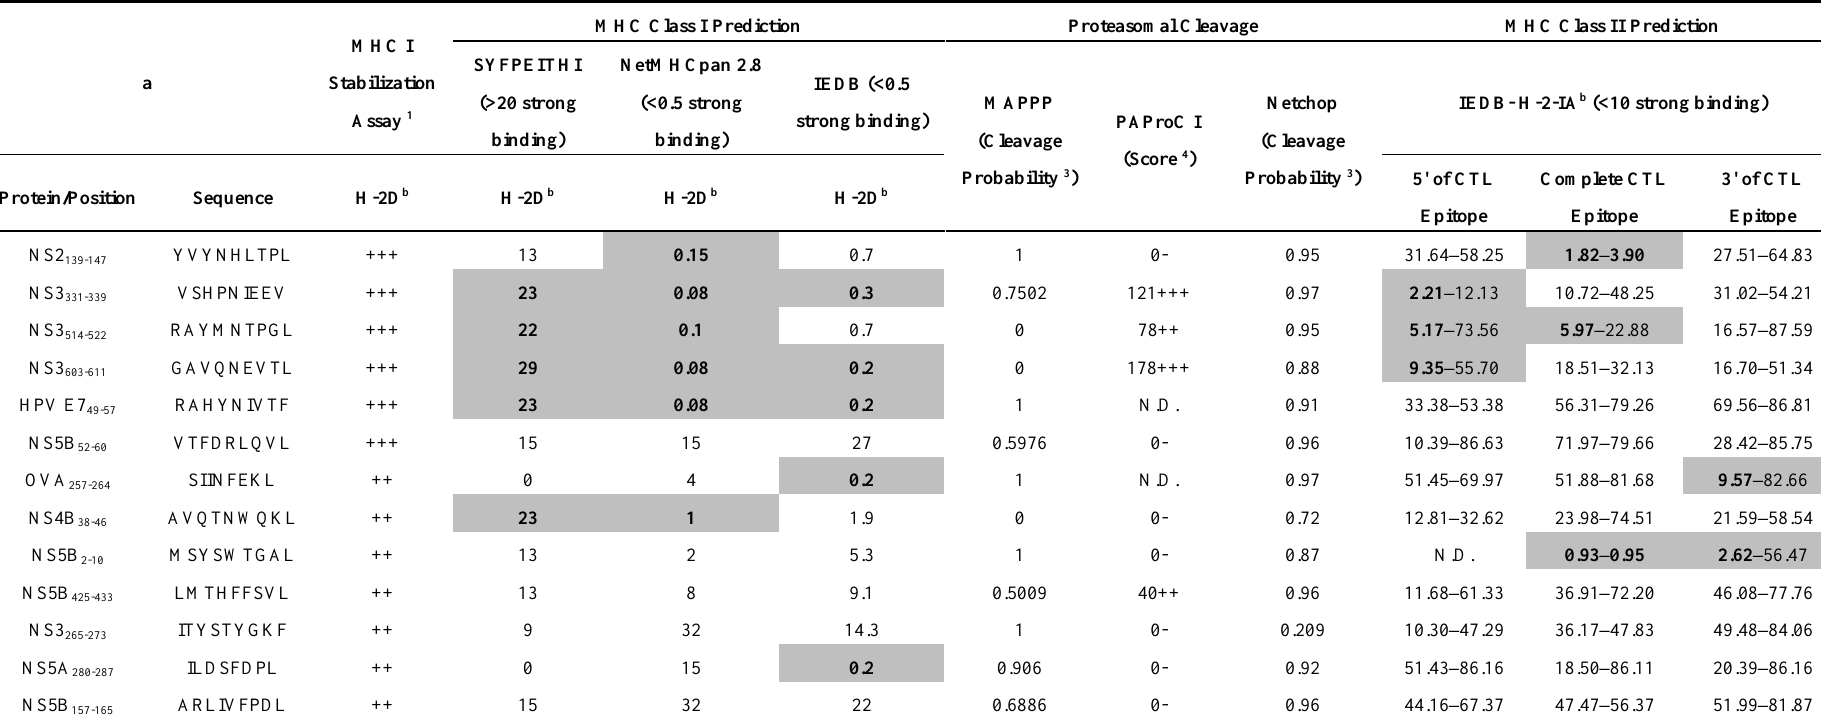
Table 2. Detailed analysis of selected short synthetic HCV peptides. Prediction of proteasomal cleavage sites and MHC class II epitopes flanking the selected CTL epitopes for ( a ) H-2D b , ( b ) H-2K b . The CTL epitope and its flanking amino acids (11 amino acid at 5' end and 11 amino acid at 3' end of the CTL epitope) were analyzed with the MHC class II prediction algorithm (IEDB). Rankings below 10 were considered strong binders. The values represent the ranking range for the analyzed amino acids. Data were sorted according to the binding affinity of short peptides to RMA-S cells (Figure 2), strong binders at the top of the row ( a : H-2D b ; b : H-2K b ). N.D. not determined. Strong binders are depicted in bold and highlighted in